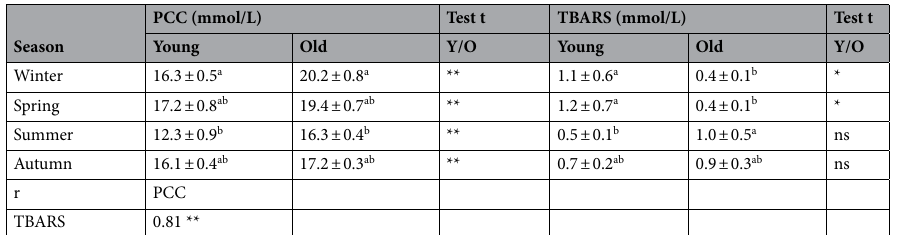
content in age groups for the summer-autumn seasons. The correlation between PCC and TBARS was 0.812 and was statistically, highly significant ( P < 0.01). Analyzing the concentration of TP (Table 5) in the blood, it was found that it increased with warmer seasons. The difference between older and younger bulls was significant ( P < 0.05) in the spring-winter seasons, and in the following seasons no significant differences between the age groups were found. In terms of ALB concentration, the results remained at a similar level throughout the study period, reaching the lowest values in winter and spring, respectively (Y: 32.0; O: 34.4 g/L and Y: 33.2; O: 37.1 g/L), and the highest in summer and in the fall (Y: 36.1; O: 35.0 g/L and Y: 34.7; O: 34.5 g/L). The lowest AU values in both bull age groups were observed in winter